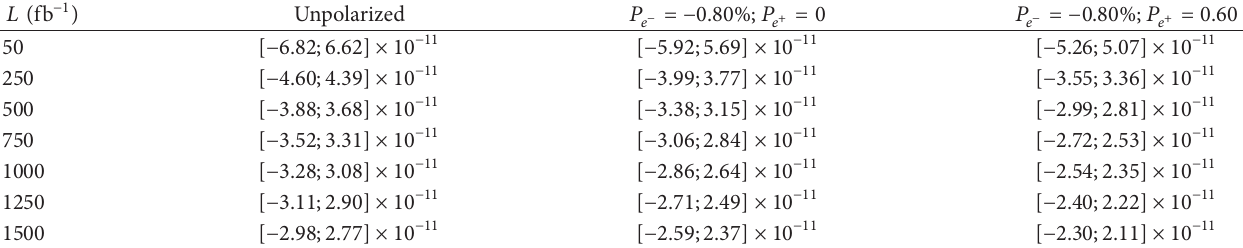
Table 5: Sensitivity of 𝑓 𝑆1 /Λ 4 at 95% CL for √𝑠 = 1.4 TeV in units of GeV −4 . 𝐿 ( fb −1 )